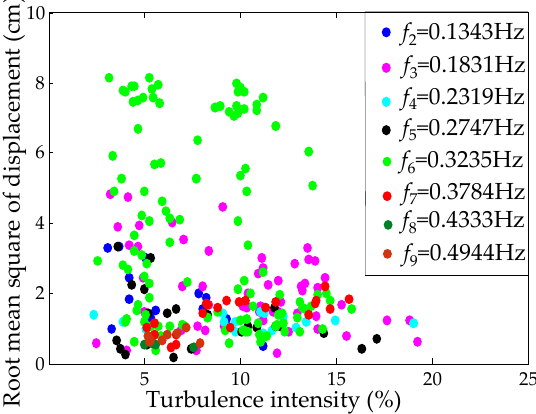
Figure 24. Relationship between turbulence intensity and root mean squares (RMS) of displacement at quarter span.